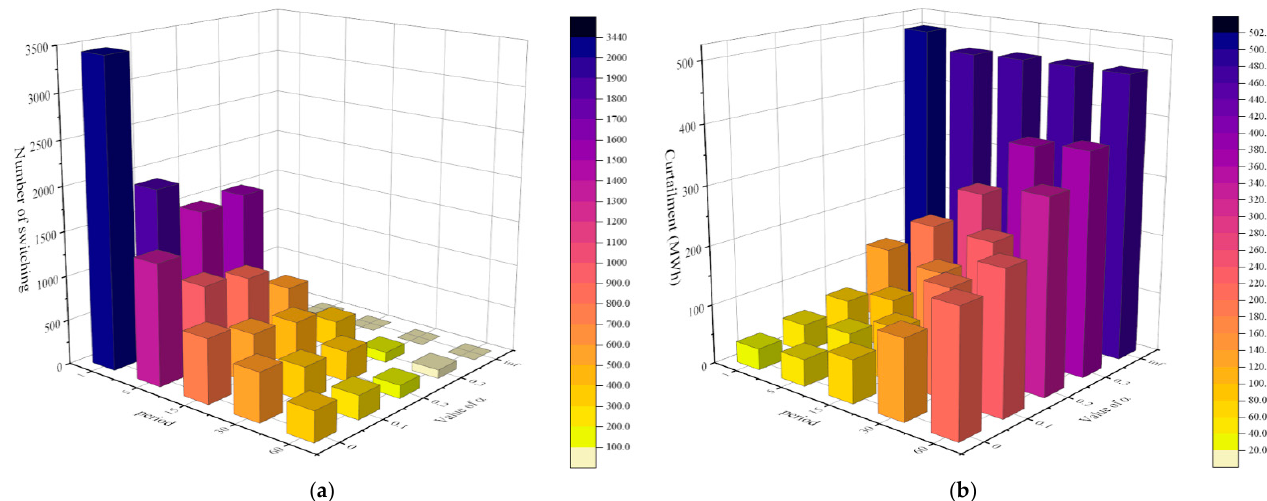
Figure 19. Number of switching operations and curtailment over 38 days with respect to α and the control period: ( a ) number of switching operations; ( b ) curtailment.